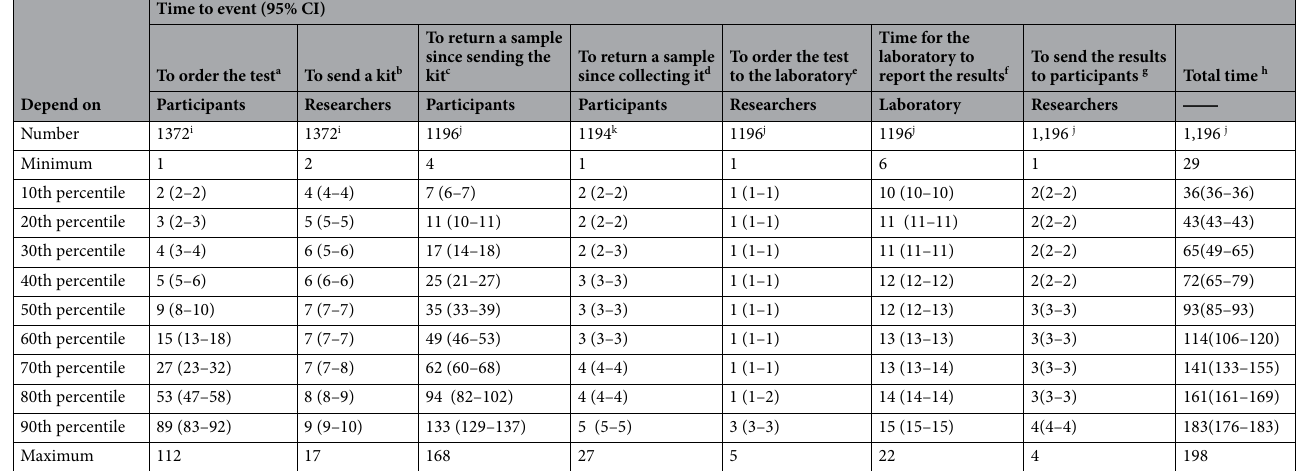
Table 4. Time to each event. Time to event was expressed in days. CI confidence interval. a Between the time that the second invitation letter was sent to the participants and the time that the self-sampling human papillomavirus (HPV) test kit was ordered by the participants. b Between the time that the self-sampling HPV test was ordered and the time that the kit was sent to the participants. c Between the time the kit was sent to the participants and the time a sample was returned. d Between the time that a sample was collected by the participants and the time the sample was returned. e Between the time that a sample was returned by the participants and the HPV test was ordered to the laboratory. f Between the time that the HPV test was ordered to the laboratory and the results were reported by the laboratory. g Between the time that the results were reported by the laboratory and the results were sent to the participants. h Between the time that the second invitation letter was sent to the participants and the time that the HPV test results were sent to the participants. i The participants to be analyzed were those who ordered the self-sampling HPV test. j The participants to be analyzed were those who returned both the sample and their written consent. k The participants to be analyzed are those who returned both the sample and their written consent and reported the data collected from a